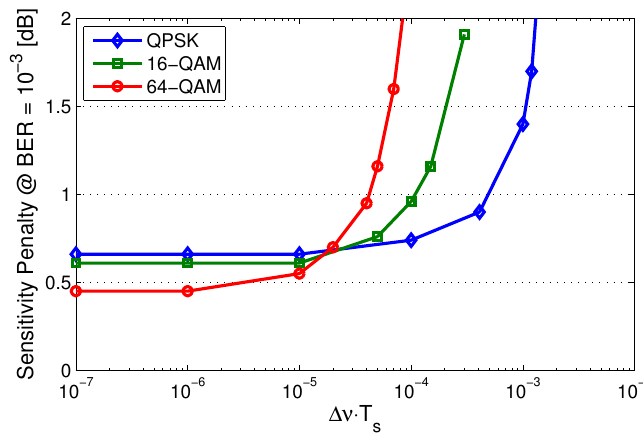
Figure 1. Sensitivity penalty at the target bit error ratio (BER) of 10 − 3 for QSPK, 16-QAM and 64-QAM.